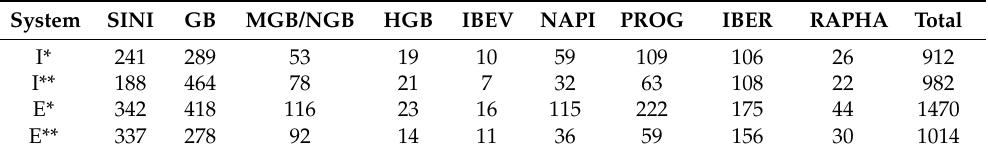
Table 3. Effect of production system and fungal infection on the composition and amount of GSLs in Albatros cv.